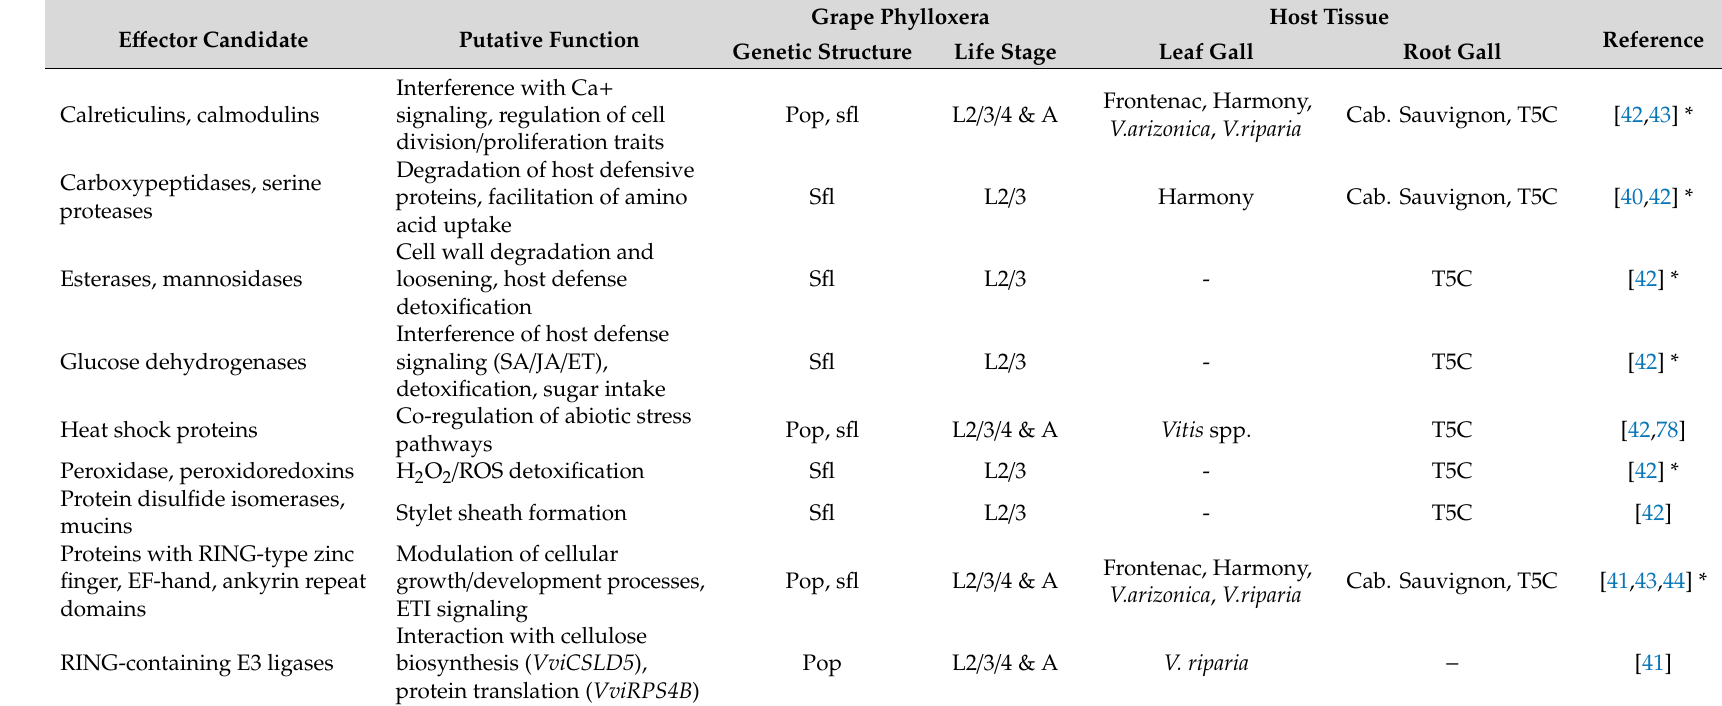
Table 3. Current overview of the grape phylloxera– Vitis interactome. The table reviews previous scientific studies targeting the grape phylloxera e ff ectors taking into account the methodological diversity of the employed insect and plant material. The first column contains the grape phylloxera e ff ector candidates, including their putative functions, as stated in the published references. “Grape phylloxera” contains information about the genetic structure and the insect life stage of the analytical insect material used. The “Host tissue” column presents the plant material of the feeding insects. It di ff erentiates between the Vitis species / cultivar and the tissue type (root versus leaf gall). Abbreviations: Pop = population; sfl = single founder lineage, T5C = rootstock Teleki 5C ( V. berlandieri × V. riparia ). * E ff ector candidates identified in feeding phylloxera larvae by the presented